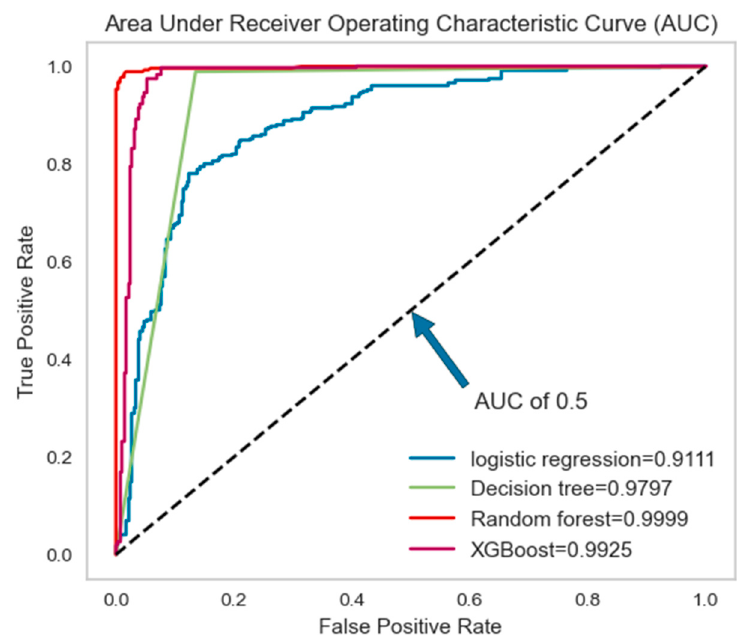
Figure 4. AUCs for up-sampled data.